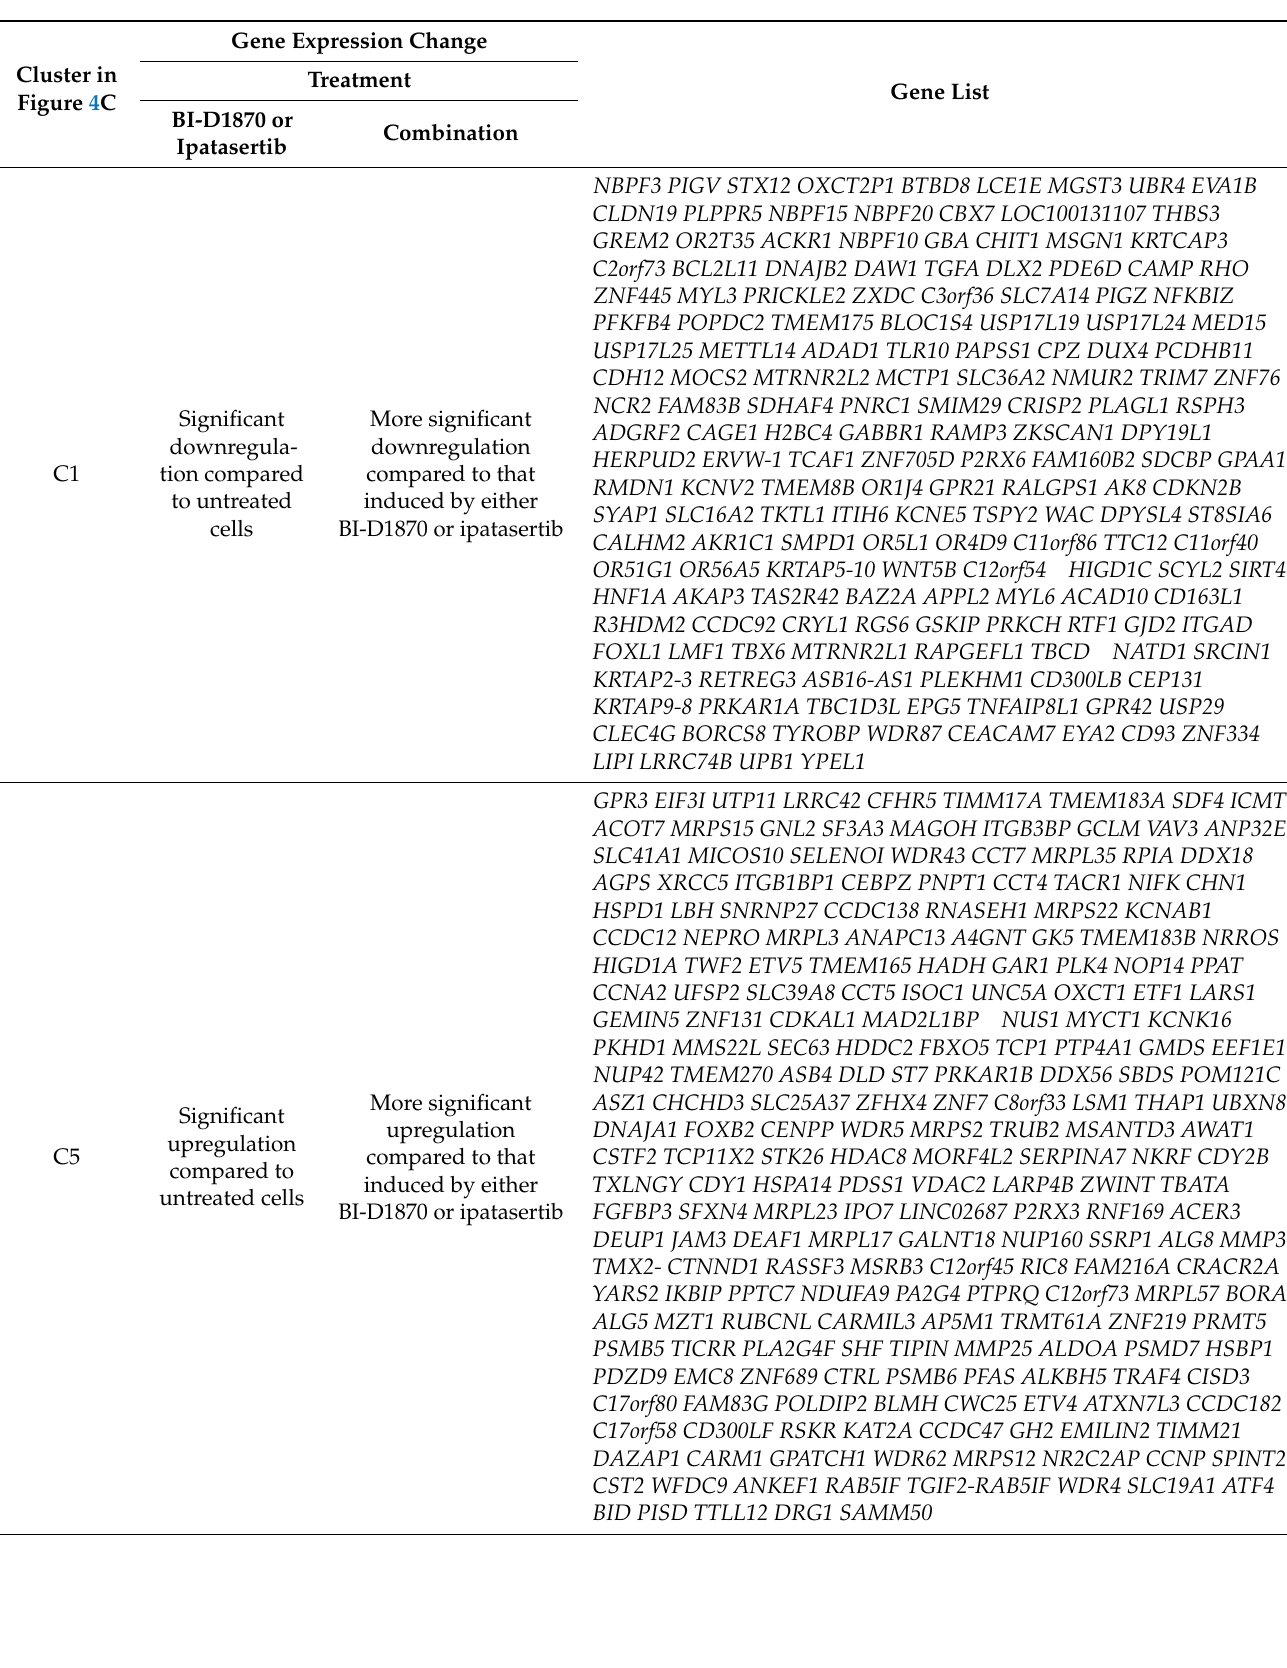
Table 1. List of significantly modulated genes by the treatment with the combination of BI-D1870 and ipatasertib. Gene lists of the clusters C1 and C5 in Figure